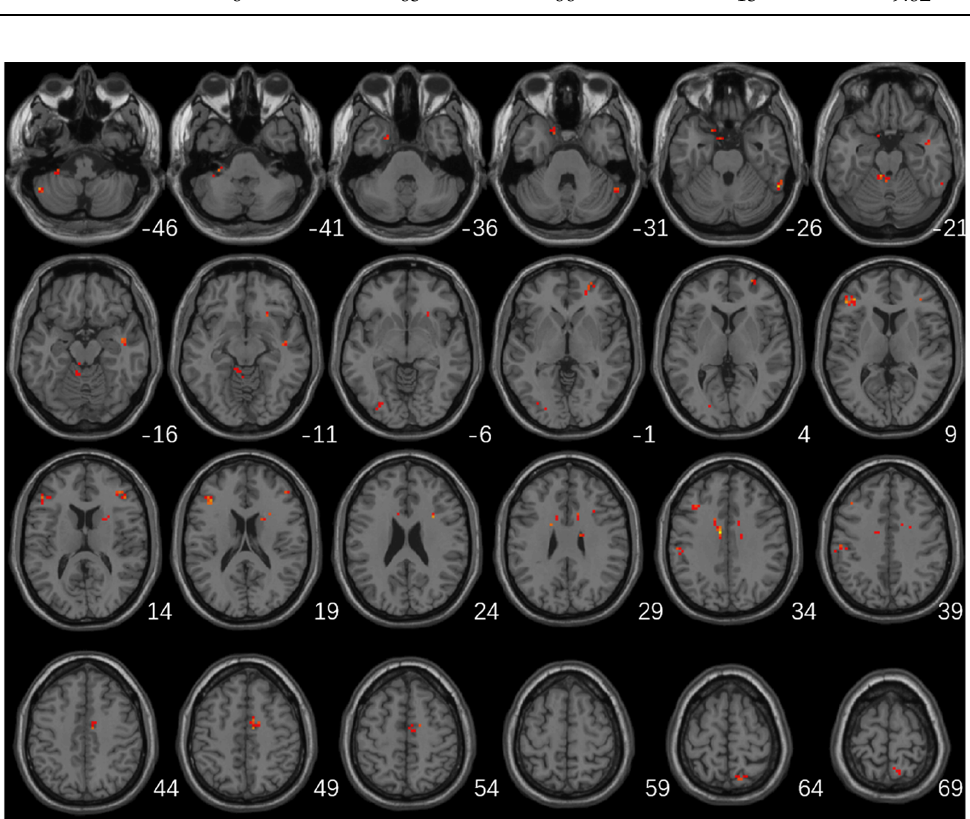
Figure 1. Brain regions with significant differences in fALFF among the three groups (GRF multiple comparison correction, p < 0.01 at the voxel level and p < 0.05 at the cluster level). The higher fALFF values within the left cerebellum, posterior cerebellum lobe, bilateral temporal lobes, and brainstem, and the lower fALFF values within the bilateral frontal lobes, right basal ganglia areas, and left inferior parietal lobule were identified in PD ‐ A patients compared with HCs (Table 3, Figure 2). Compared with HCs, PD ‐ NA patients showed increased fALFF values in the left cerebellum and cerebellum posterior lobe. In contrast, decreased fALFF values were noted in the right cuneus and left superior parietal lobe (Table 3, Figure 2). When comparing the two PD groups, increased fALFF values of the right precuneus were found in PD ‐ A patients. In contrast, decreased fALFF values were demonstrated in the bilateral frontal lobes, bilateral basal ganglia areas, left inferior parietal lobule, and left occipital lobe (Table 3, Figure 2). The fALFF values in the right precuneus ( r = 0.54, p < 0.001) were positively correlated with HAMA scores of PD ‐ A pa ‐ tients (Figure 3). Furthermore, the fALFF values in the left caudate were negatively corre ‐ lated with HAMA scores of PD ‐ A patients ( r = − 0.60, p < 0.001) according to Pearson ʹ s correlation analysis (Figure 4).